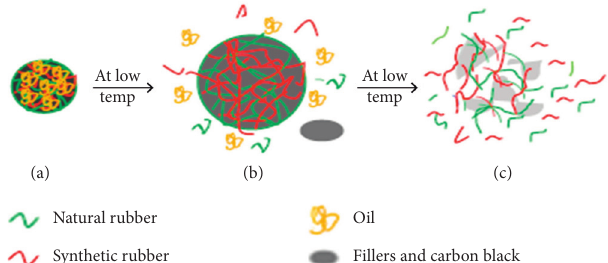
Figure 3: CR swelling and degradation in asphalt [36]. (a) Crumb rubber (CR). (b) Swollen CR, discharging oil and fillers to asphalt. (c) Breaking of